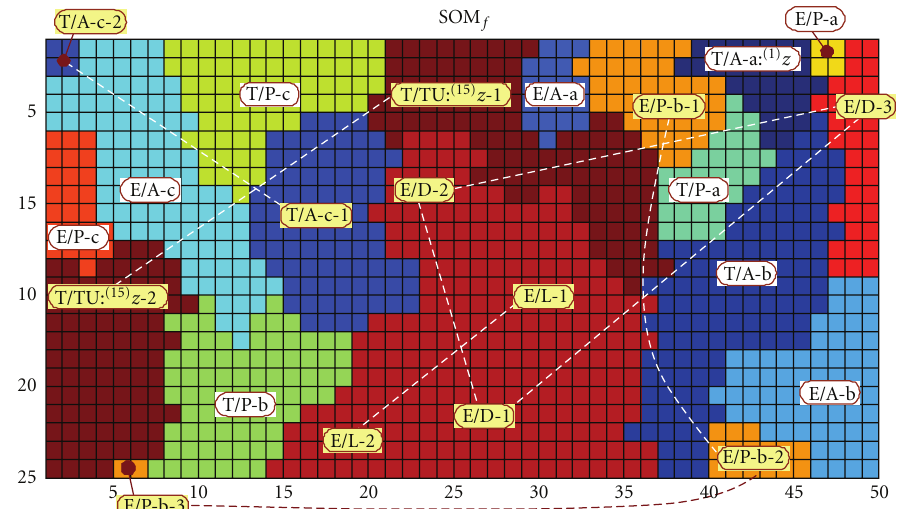
Figure 10: Clusters on the SOM f map.